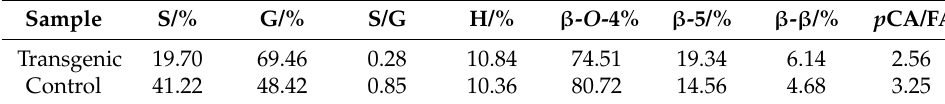
Table 5. The units and linkages proportion of switchgrass LCs.